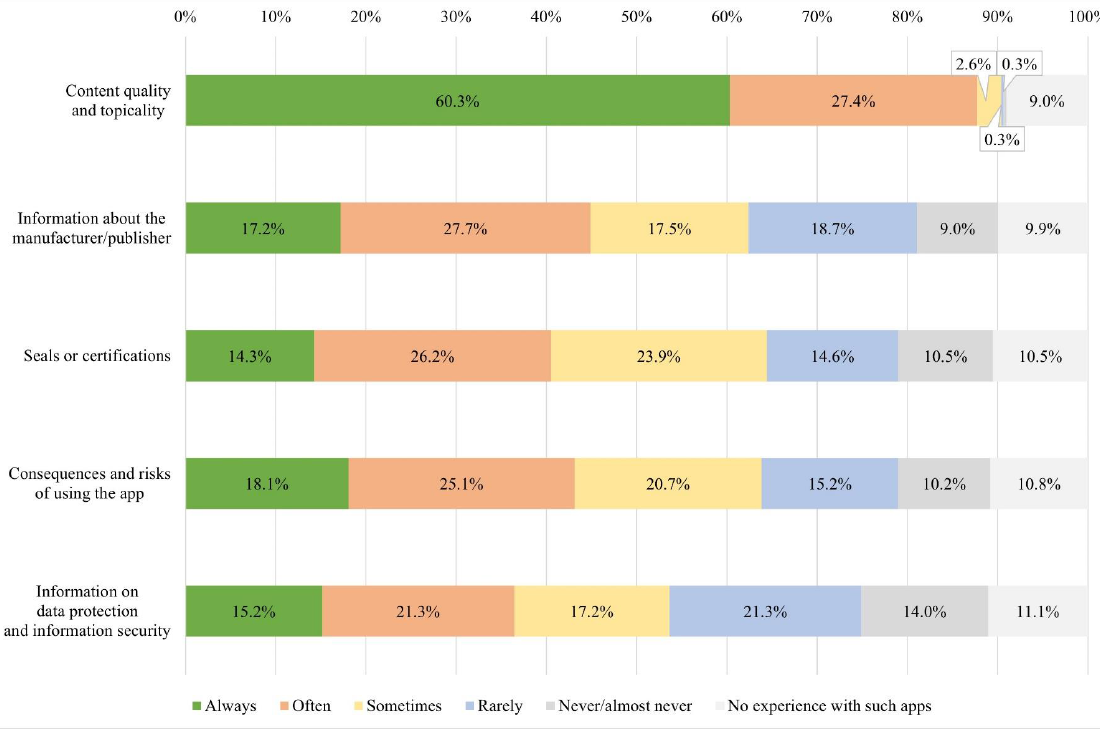
Figure A8. App Selection — Consideration of Security-related Aspects.